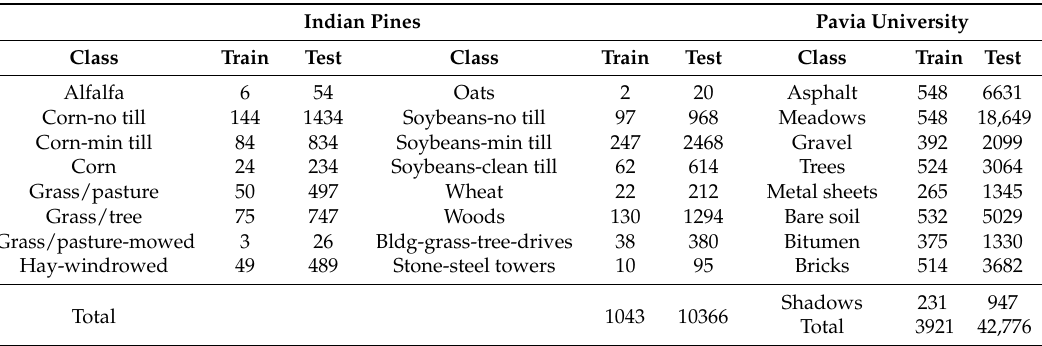
Table 1. The training sample and test samples of Indian Pines and Pavia